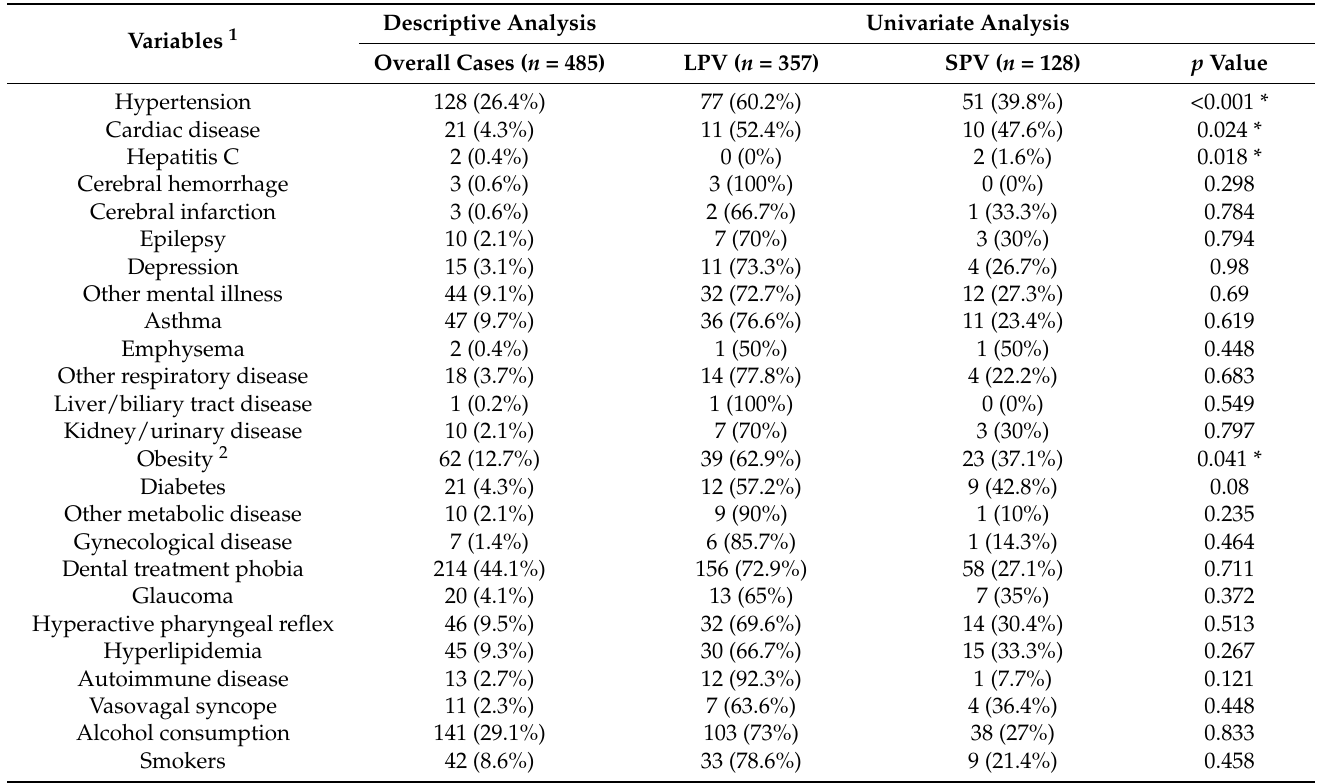
Table 3. Descriptive and univariate analysis of medical history variables from overall reviewed cases.